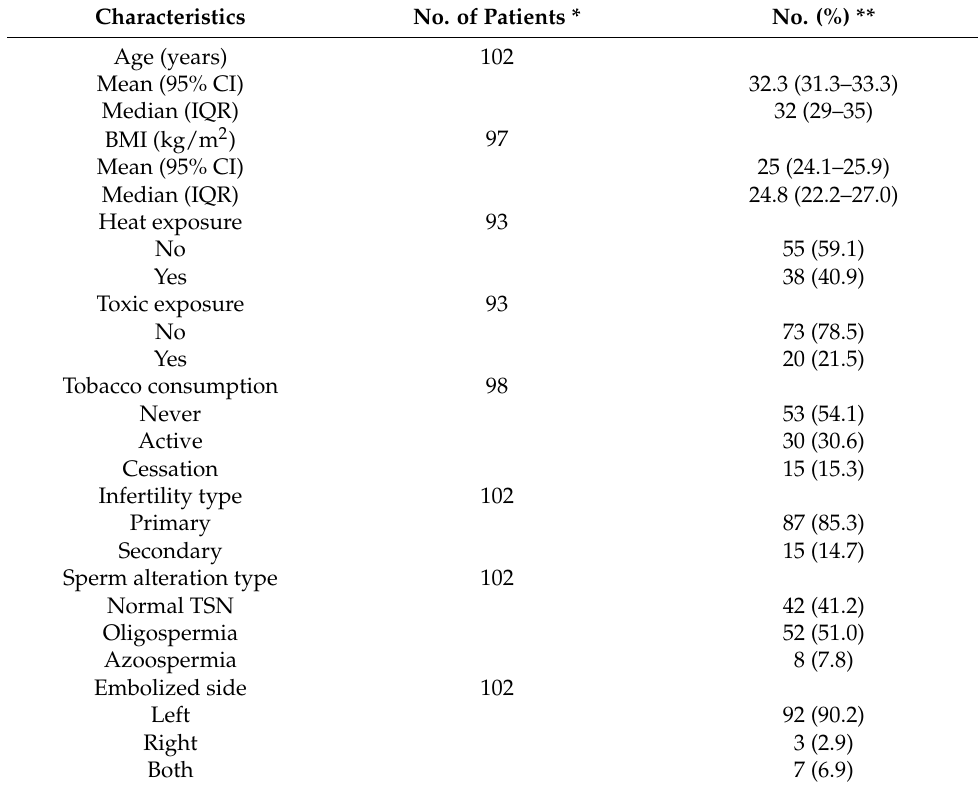
Figure 2. Flow chart of patients’ selection. VE, varicocele embolization; NBCA-MS, n-butyl cyanoacrylate metacryloxysulfolane. Table 1. Patients characteristics.